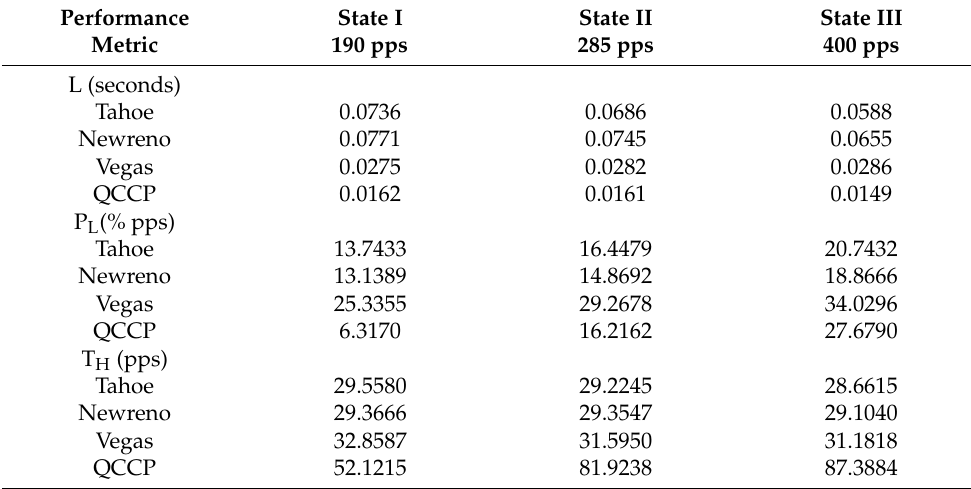
Table 5. Experimental result summary of second